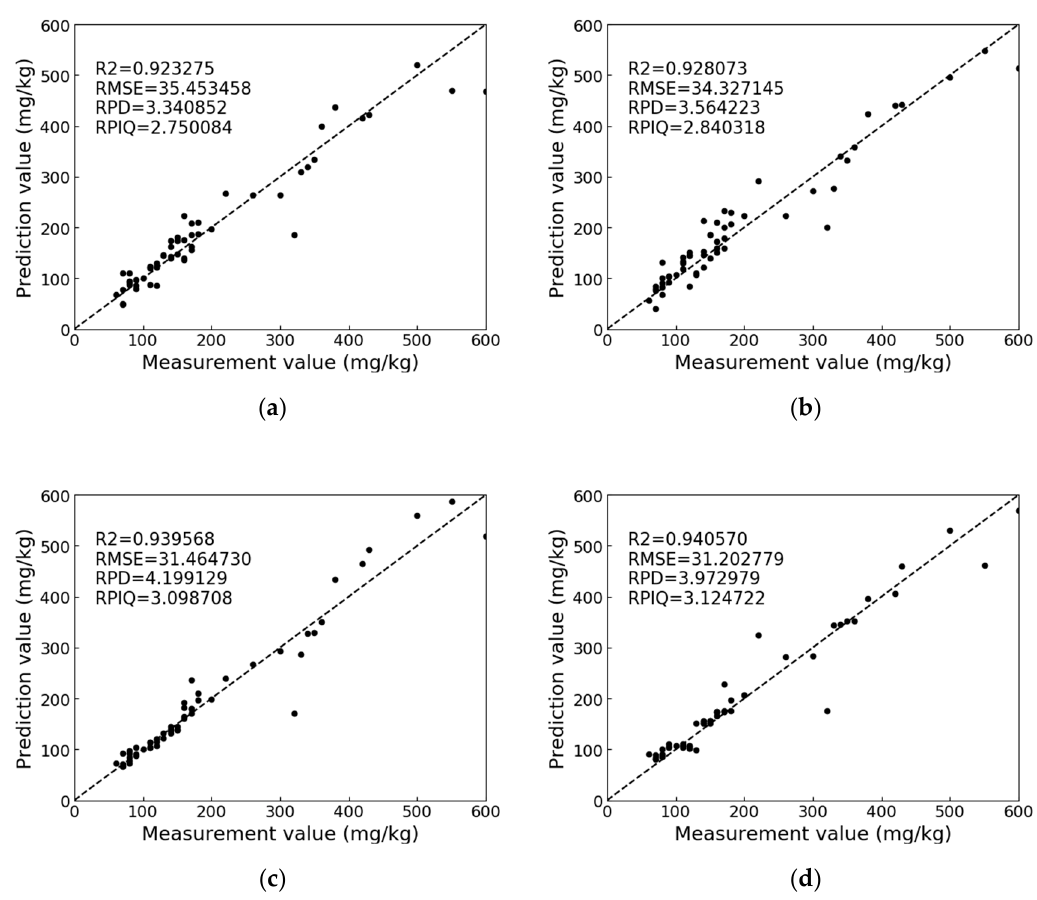
Figure 8. Scatter plots of different models with RPD level A. ( a ) SVR_RBF; ( b ) PLS_RBF; ( c ) GBRT; ( d ) AdaBoost.